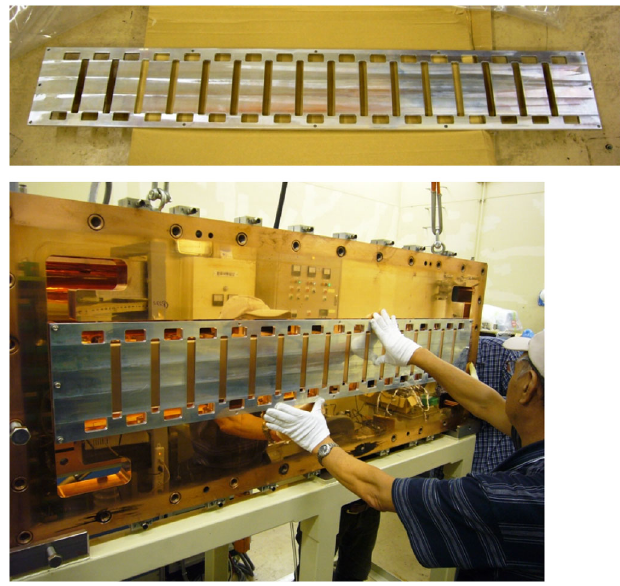
FIG. 21. Jig for stem installation.